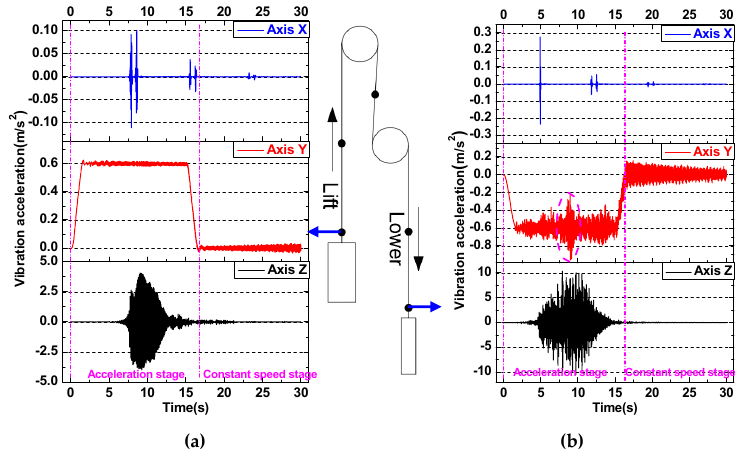
Figure 10. Vibration acceleration in three directions of the rope at 0.5 m. ( a ) Above the cage; ( b ) above the hammer.